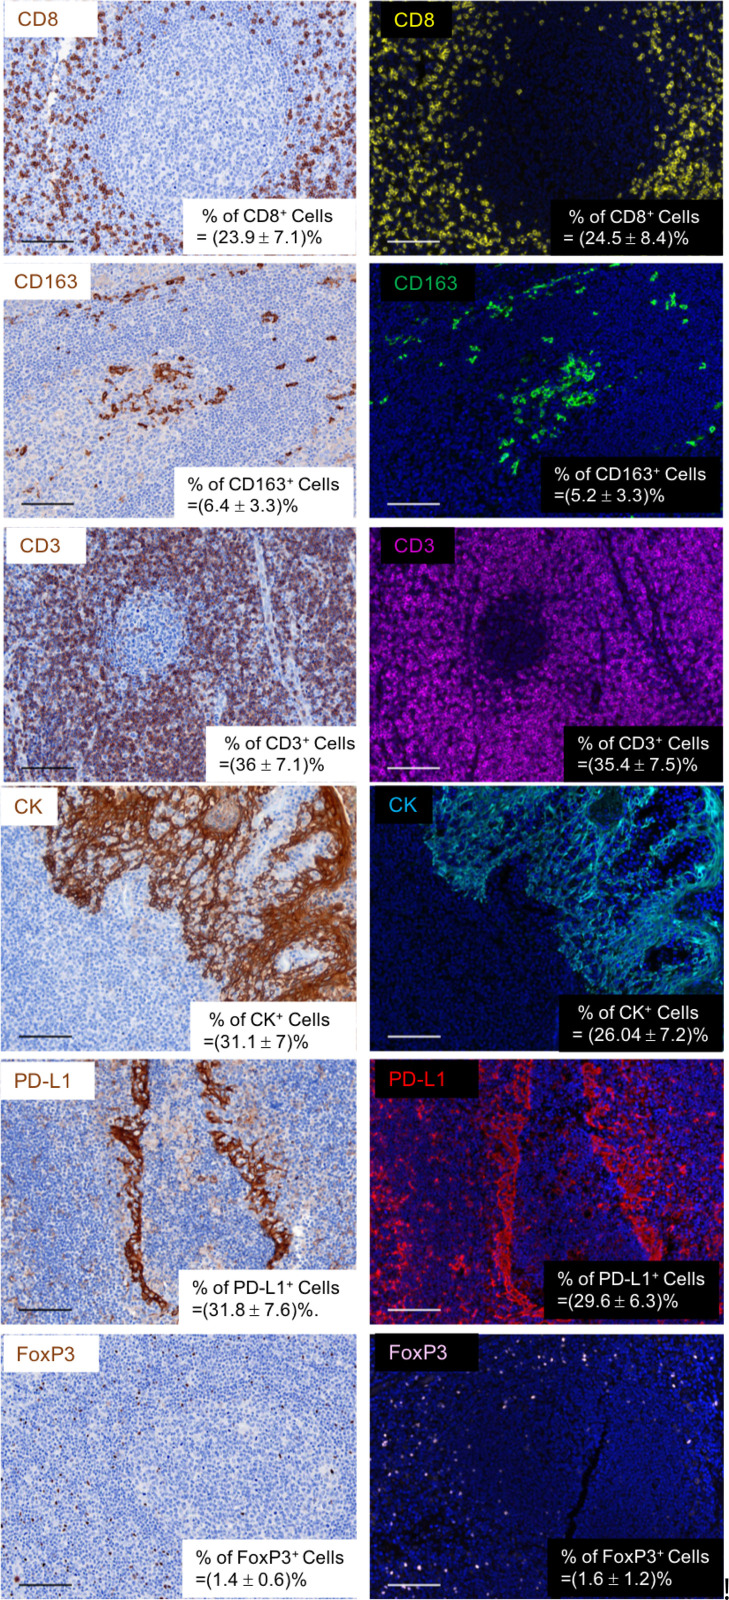
Chromogenic vs. Opal: Validation of singleplex Opal fluorescent stains in human FFPE tonsil tissue specimens.The optimized titrations of primary antibodies (CD8, CD163, CD3, FoxP3, PD-L1, and CK) which used Tris-EDTA pH9.0 to retrieve antigens in singlepex chromogenic stain were transferred to Opal fluorescent stain on the adjacent slides. The frequency (mean+/-SD) of each biomarker was determined.